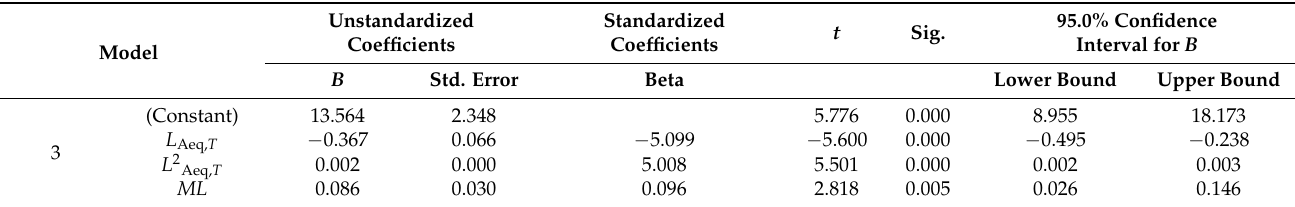
Table 9. Multiple regression and correlation analysis of the selected model.